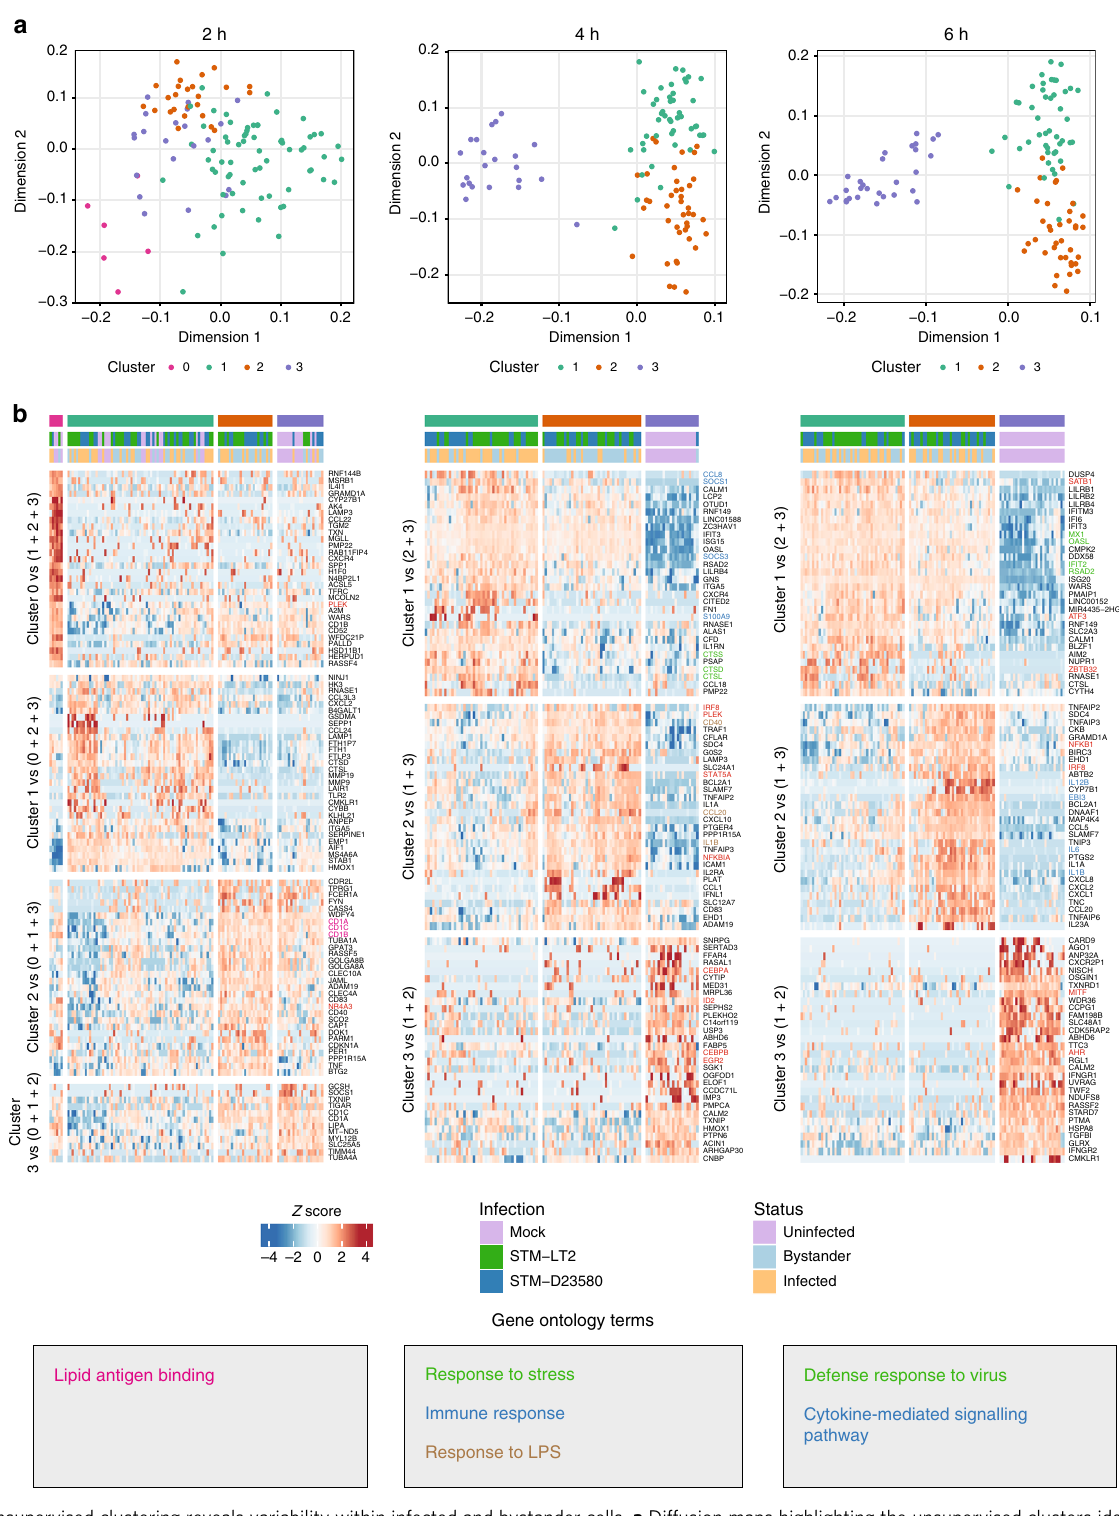
Fig. 2 Unsupervised clustering reveals variability within infected and bystander cells. a Diffusion maps highlighting the unsupervised clusters identi fi ed by rank correlations between gene expression pro fi les of cells at each time point separately. Diffusion maps were computed on the fi rst 50 components of a principal component analysis (PCA) using the 500 most variable genes identi fi ed within cells at each time point separately. b Heat maps displaying up to 30 signi fi cant marker genes identi fi ed as DE genes ( P -value < 0.01) between each unsupervised cluster and all other cells at the corresponding time point (2, 4 and 6 h p.i, respectively). Rows and columns were clustered using Euclidian distance and complete linkage method applied to the row-scaled values across all heat map panels at that time point. Enriched GO categories and associated genes are indicated by colors. Transcription factors are highlighted